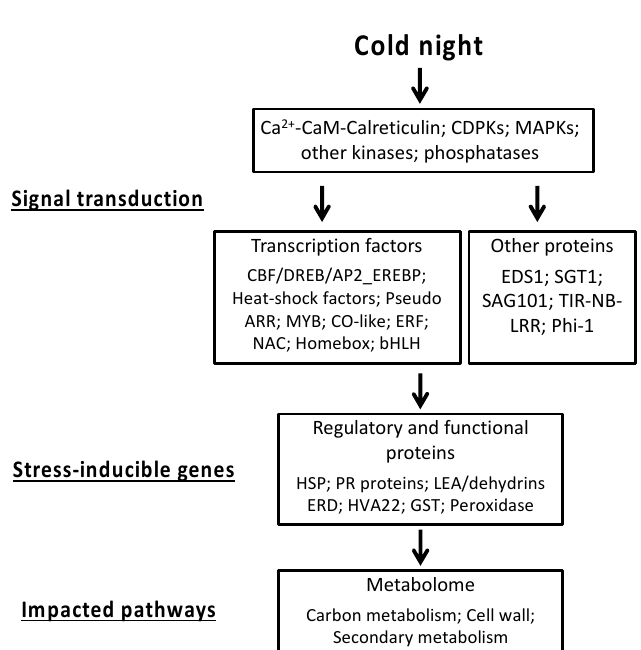
Figure 10. Schematic representation of the major mechanisms involved in the response of the Vitis flower to a cold night. Signal transduction pathway, stress-inducible genes, and major impacted pathways following the exposure of grapevine flowers to a cold night.